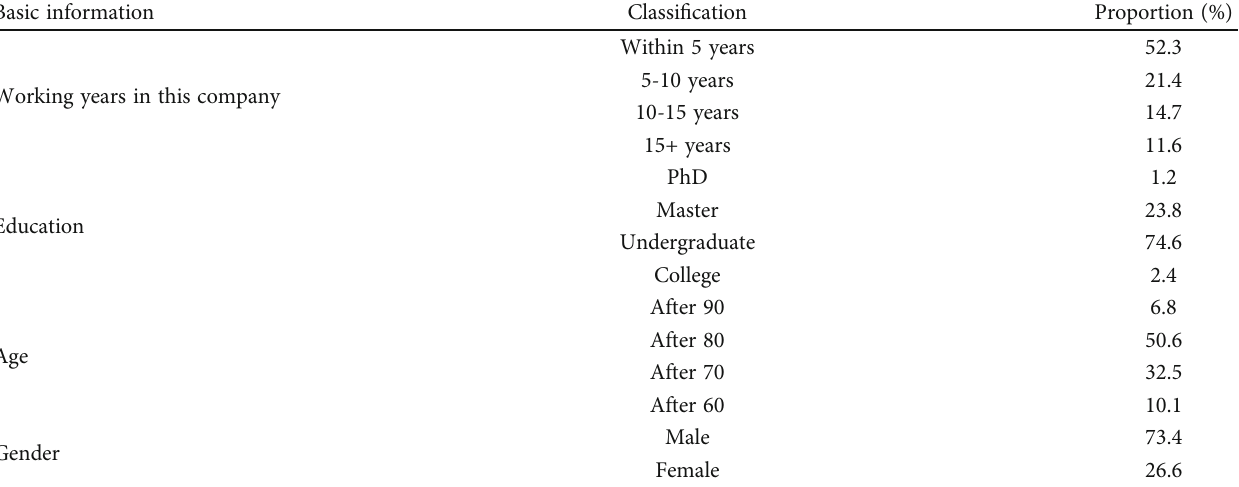
Table 3: Survey results of demographic